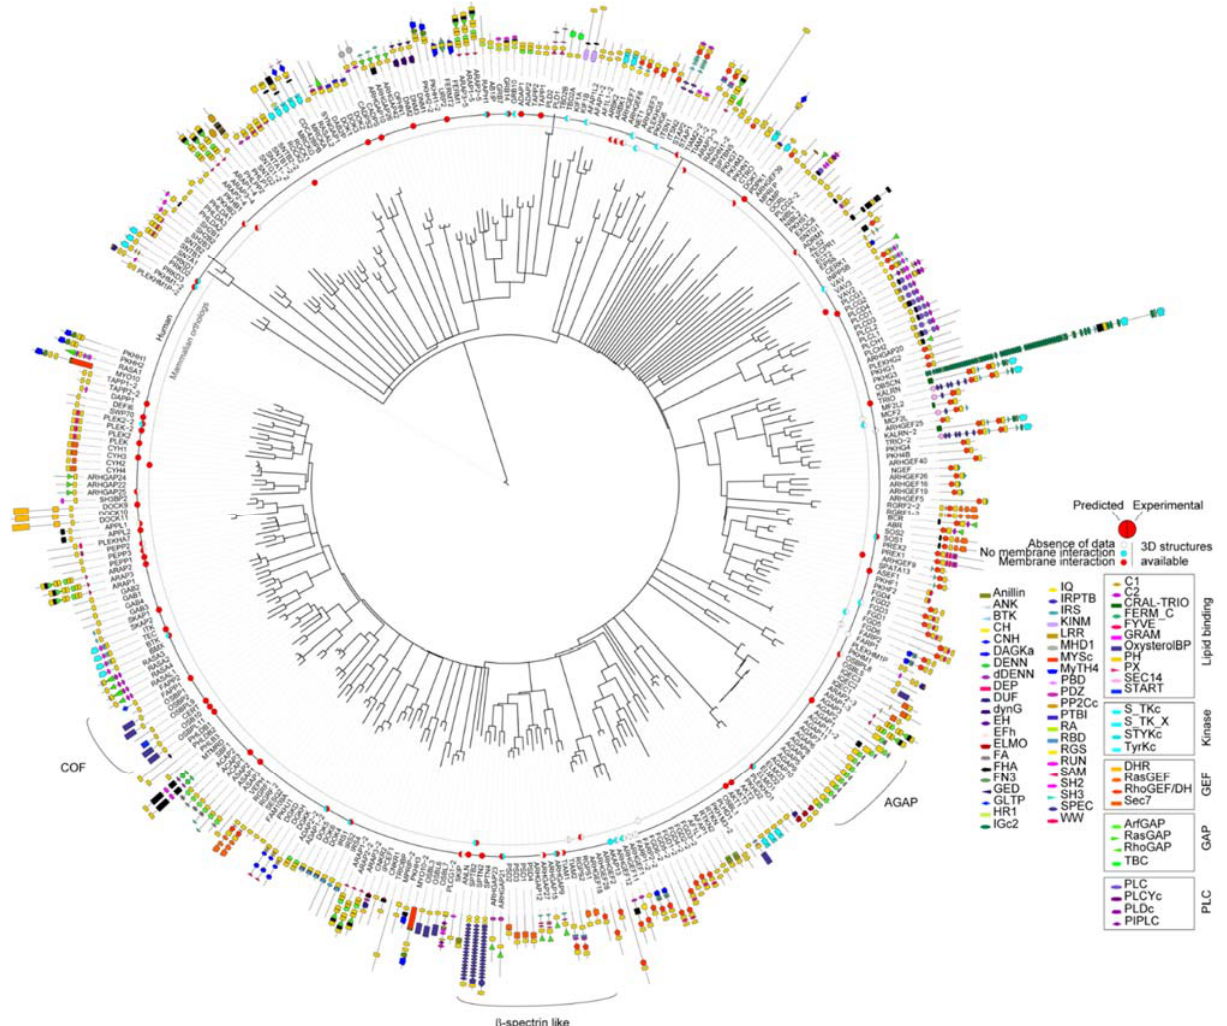
Figure 2. Diagram of the relatedness of human proteins based on PH domain sequence similarity. The tree was built for the human PH domains with distances indicating similarities using Itol [13]. For each PH domain, the modular architecture is indicated and the length of the protein is represented by a line whose inner extremity corresponds to the start of the protein. For proteins containing several PH domains, each PH domain is numbered according to its relative position within the protein. Deposited PH domain structures from human and mammalian sources are indicated by a disc that is colored to indicate the experimental and predicted membrane binding functions. Experimental evidence of the binding was considered only when the role of the PH domain was specifically examined rather than the entire protein. Protein domains are grouped by functions, GAP, GEF, kinase/phosphatase and membrane binding. Abbreviations of the protein domains are indicated in